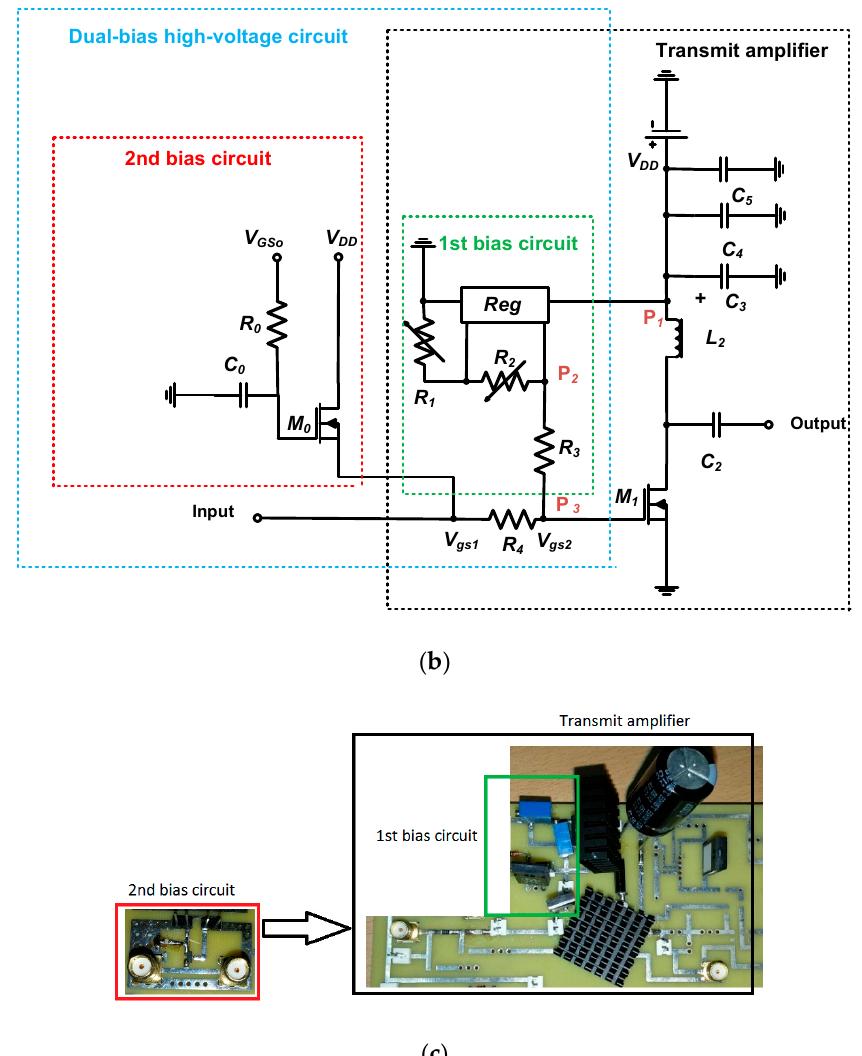
Figure 3. ( a ) Block diagram, ( b ) schematic diagram, and ( c ) PCB of the transmit amplifier integrated with dual-bias high-voltage circuit.